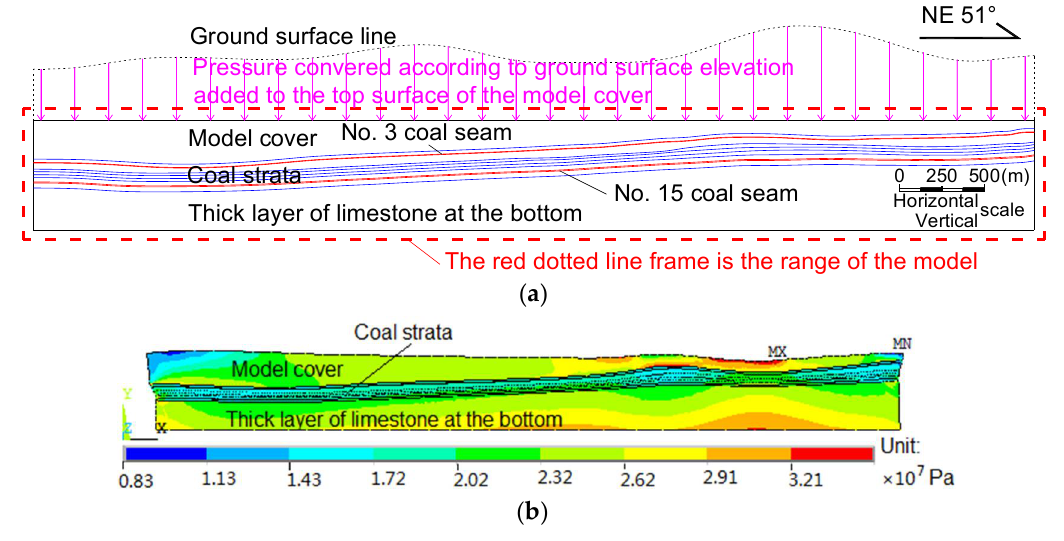
Figure 4. Modeling and simulation results of profile IV–IV. ( a ) The establishment of a 2D profile geological model; and ( b ) An equivalent stress cloud map of a profile.